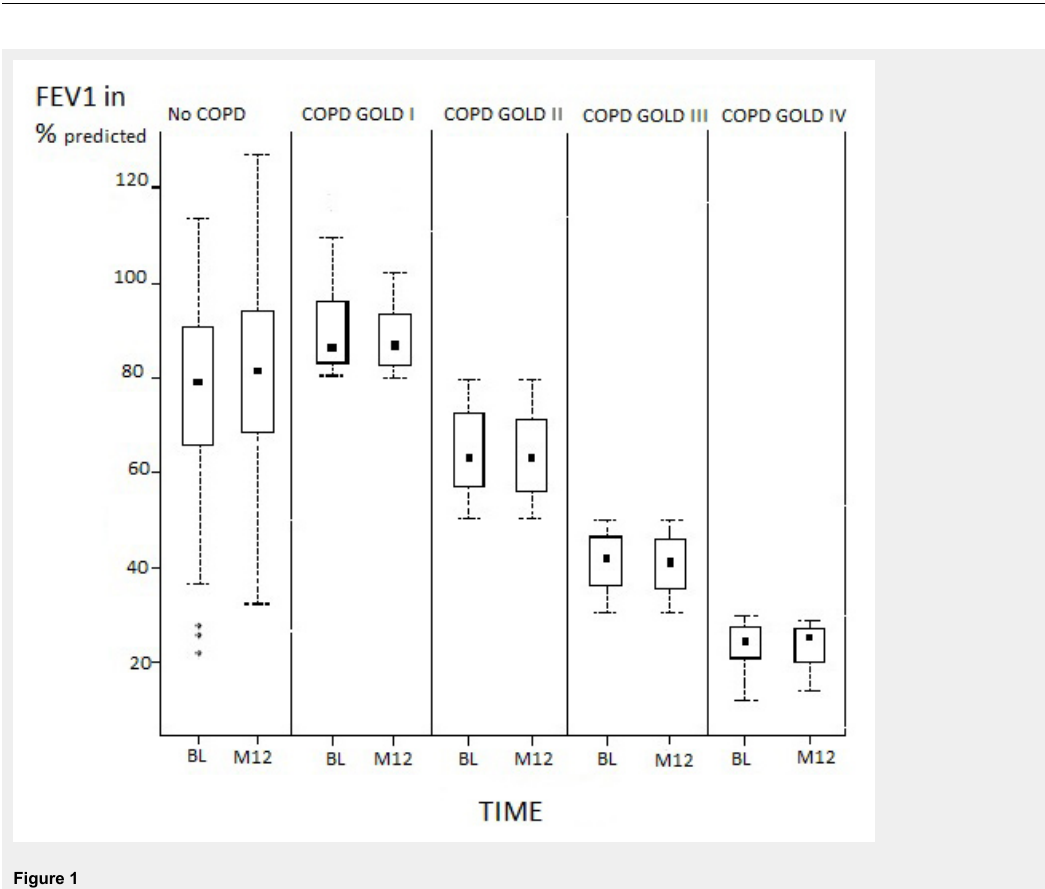
Figure 1 Trend of FEV 1 over 12 months. Comparison of average FEV 1 predicted in different COPD groups at BL and after 12 months. Abbreviations: FEV 1 , forced expiratory volume in 1 second; COPD, chronic obstructive pulmonary disease; GOLD, Global Initiative for Chronic Obstructive Lung